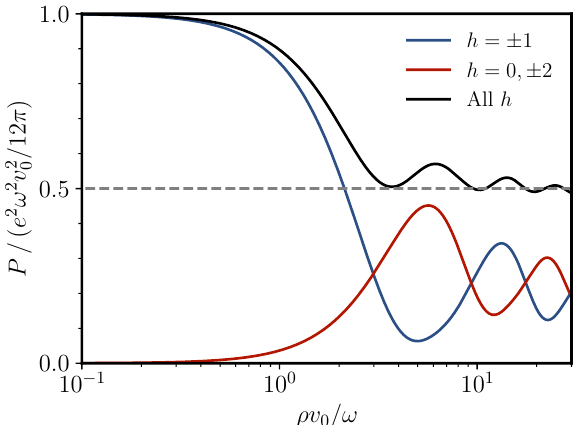
Figure 1 . Power radiated by an nonrelativistic oscillating charged particle, normalized to the ordinary Larmor result, for a photon with spin scale ρ . We show power emitted into the ordinary helicities h = ± 1 , the “nearest neighbor” helicities h = 0 , ± 2 , and the total in all integer